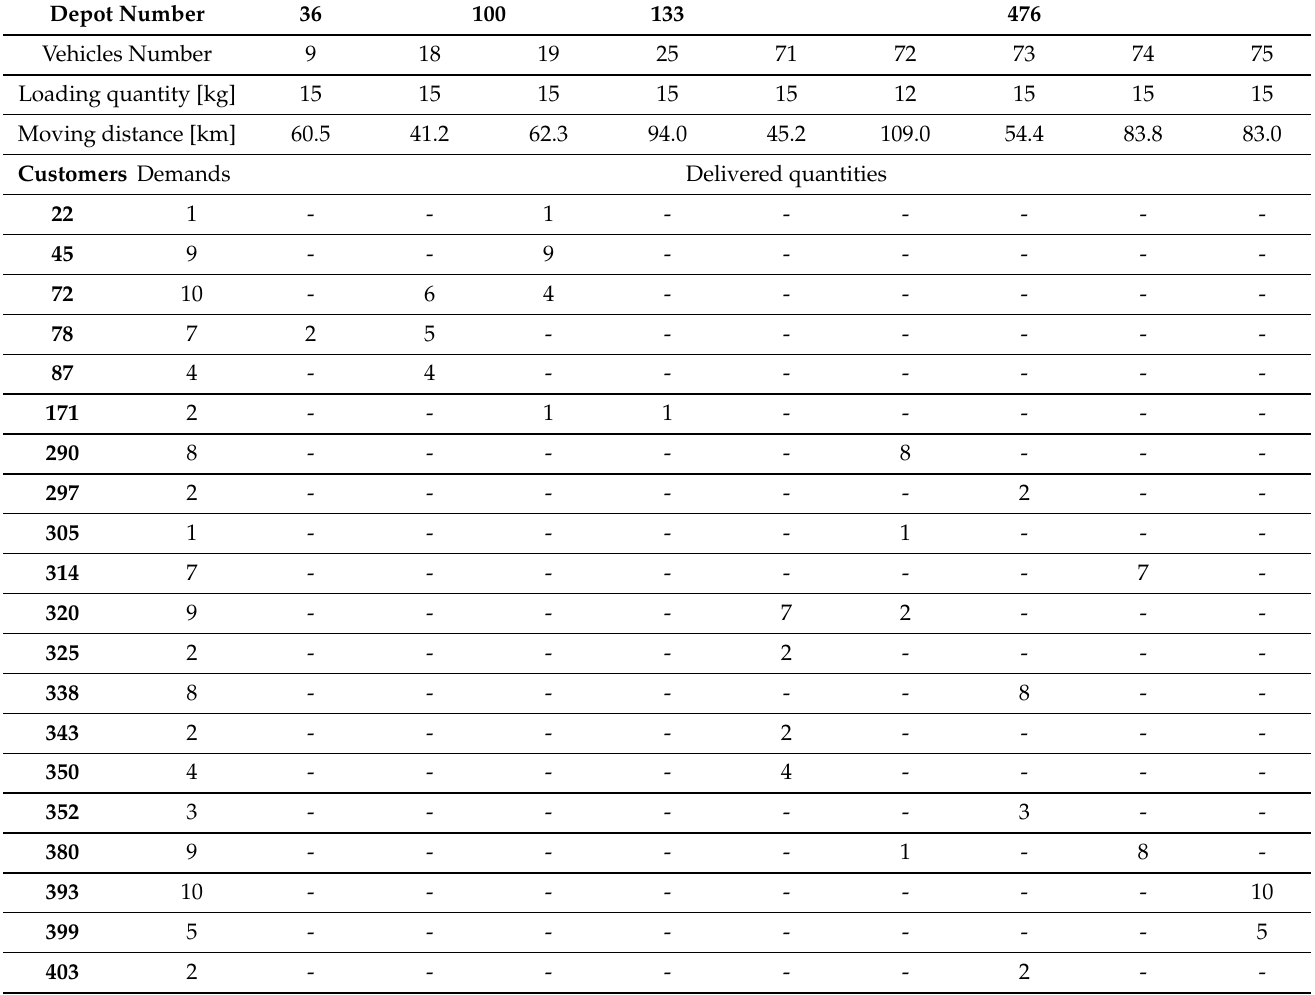
Table 3. Quantities delivered by UAVs registered at depots 36, 100, 133, and